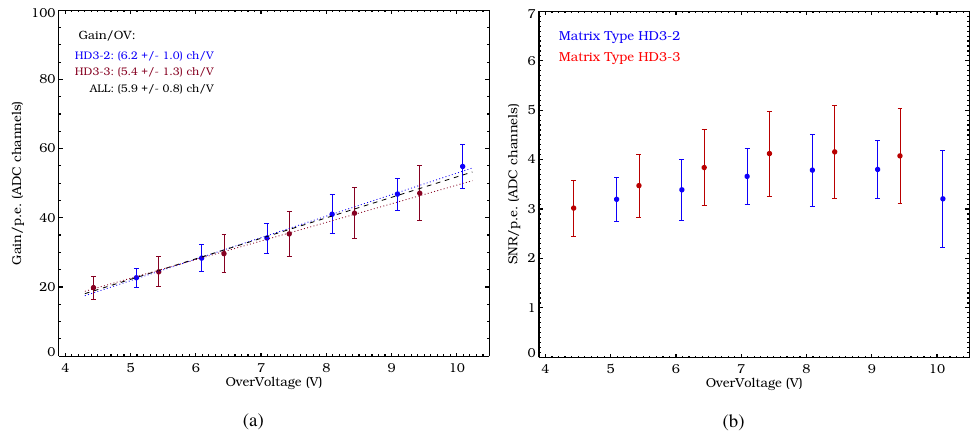
Figure 2: Average values of gain ((a)) and SNR ((b)) as a function of OV of all the studied channels of the HD3-2 and HD3-3 matrices. Figure 2. Average values for gain (a) and signal to noise ratio (SNR) (b) for more than 50 modules made of HD3-2 (blue) and HD3-3 (red)